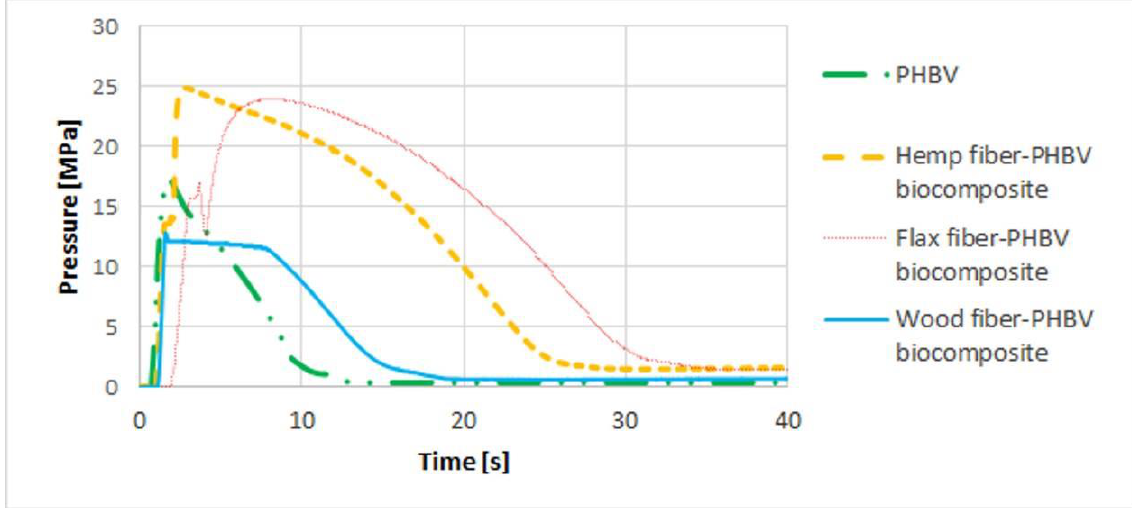
Figure 3. The pressure profile in mold cavity for biocomposites with a variable type of filler and pure biopolymer.